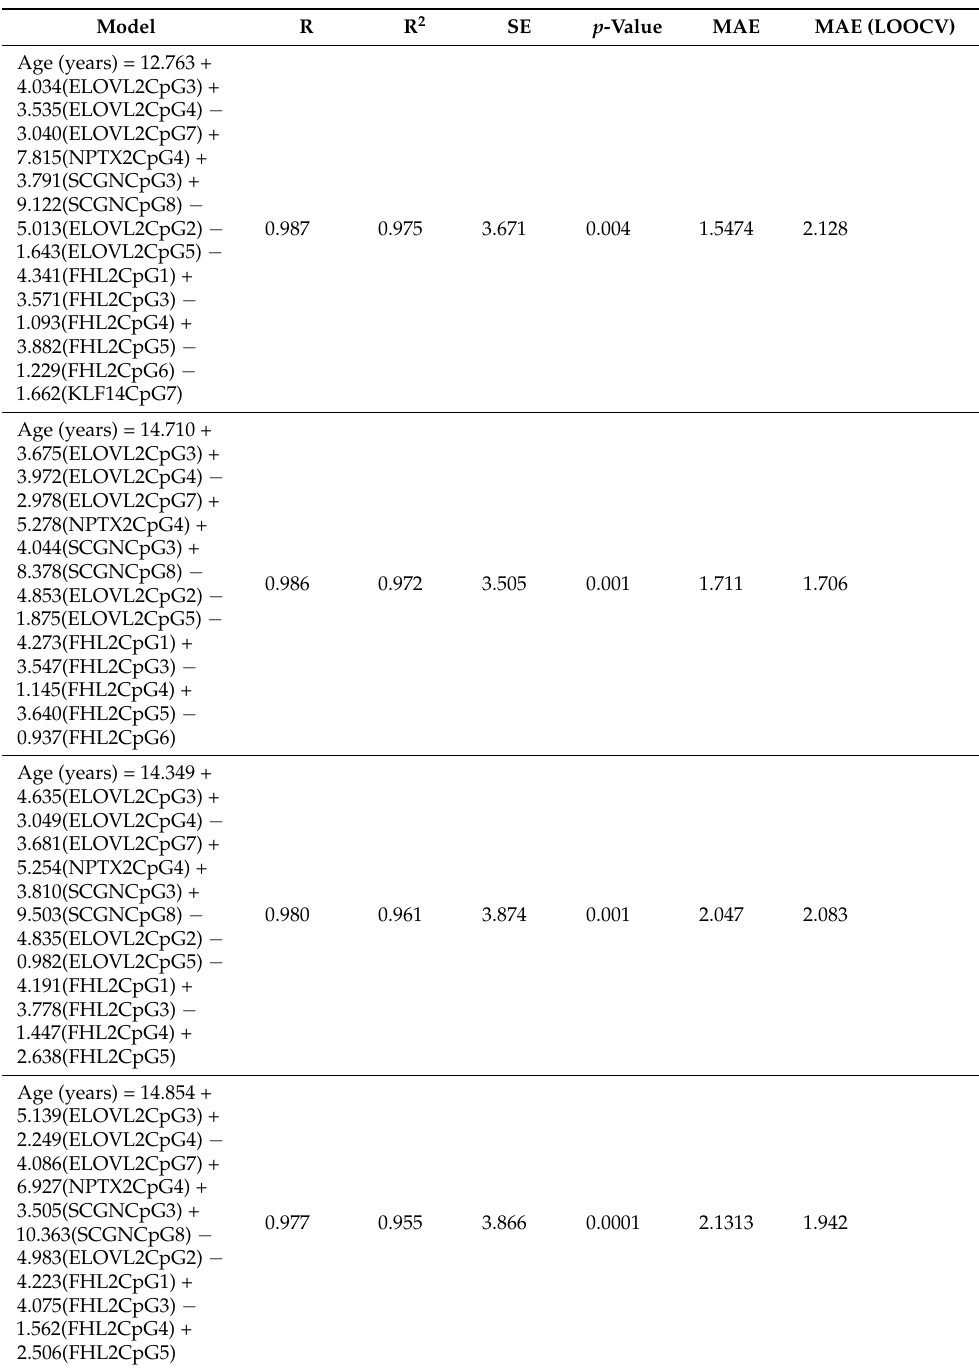
Table 2. Prediction models for age estimation in pulp. MAE, Mean Absolute Error; LOOCV, leave- one-out